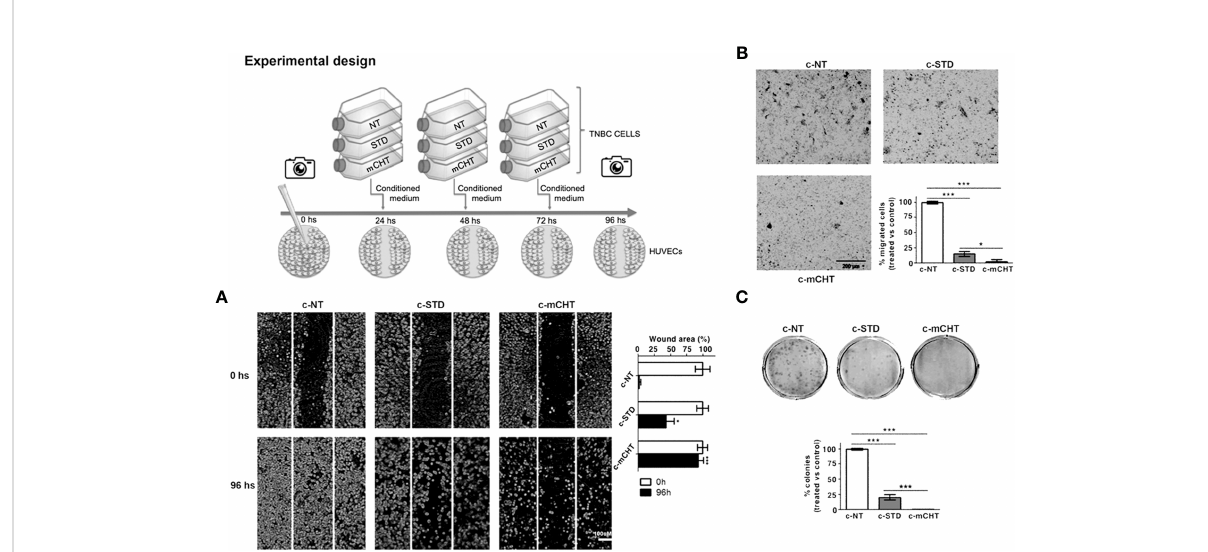
FIGURE 9 Conditioned medium from metronomically 5-FU+VNR-treated MDA-MB-231 cells suppresses HUVECs migration and colony formation. Schematic drawing of the experimental design. (A) Representative images of scratch tests performed on HUVECs before (0h) and 96h after treatment with conditioned medium from MDA-MB-231 cells treated with 5-FU+VNR given STD (c-STD) or mCHT (c-mCHT). Conditioned medium from untreated MDA-MB-231 (c-NT) was used as control. The area of the still open wound after 96h is quanti fi ed as a percentage of the initial scratched area. Values represent the average ± SD of three independent experiments, *p <0.05; ***p <0.001. (B)